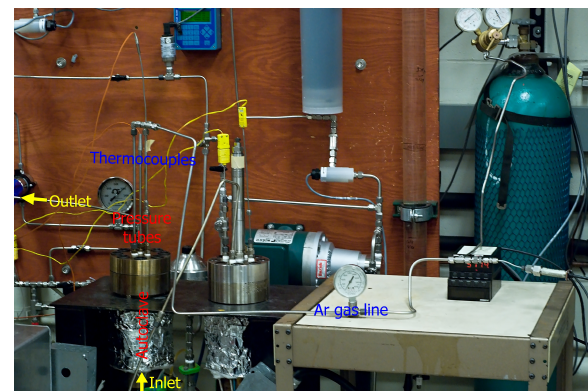
Figure 6. Photo of the autoclaves, gas system and water